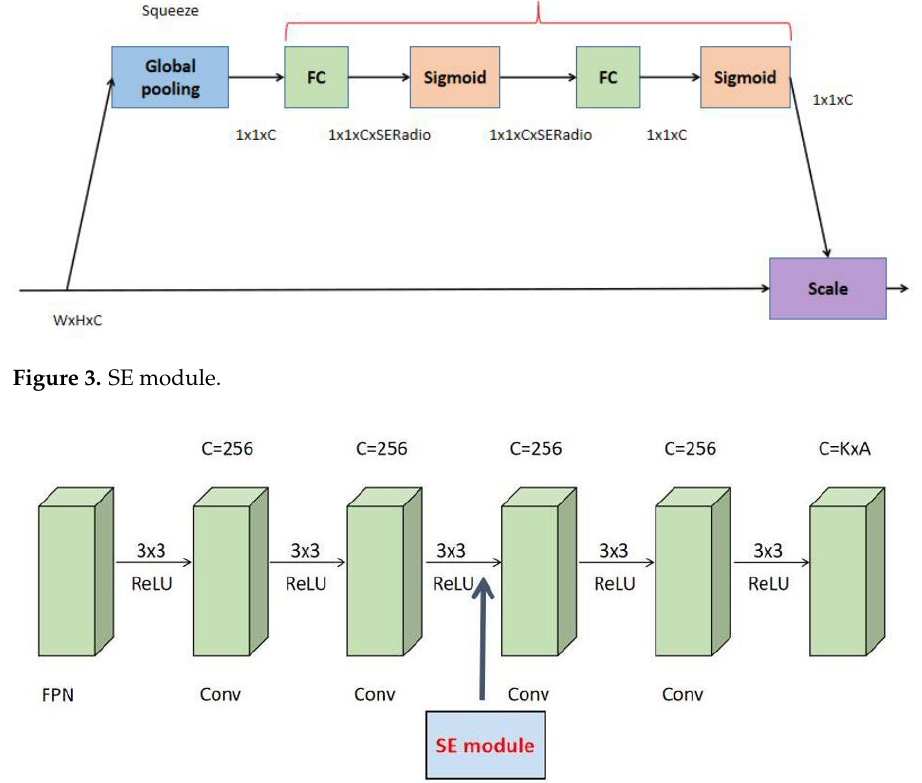
Figure 4. Location diagram of the SE